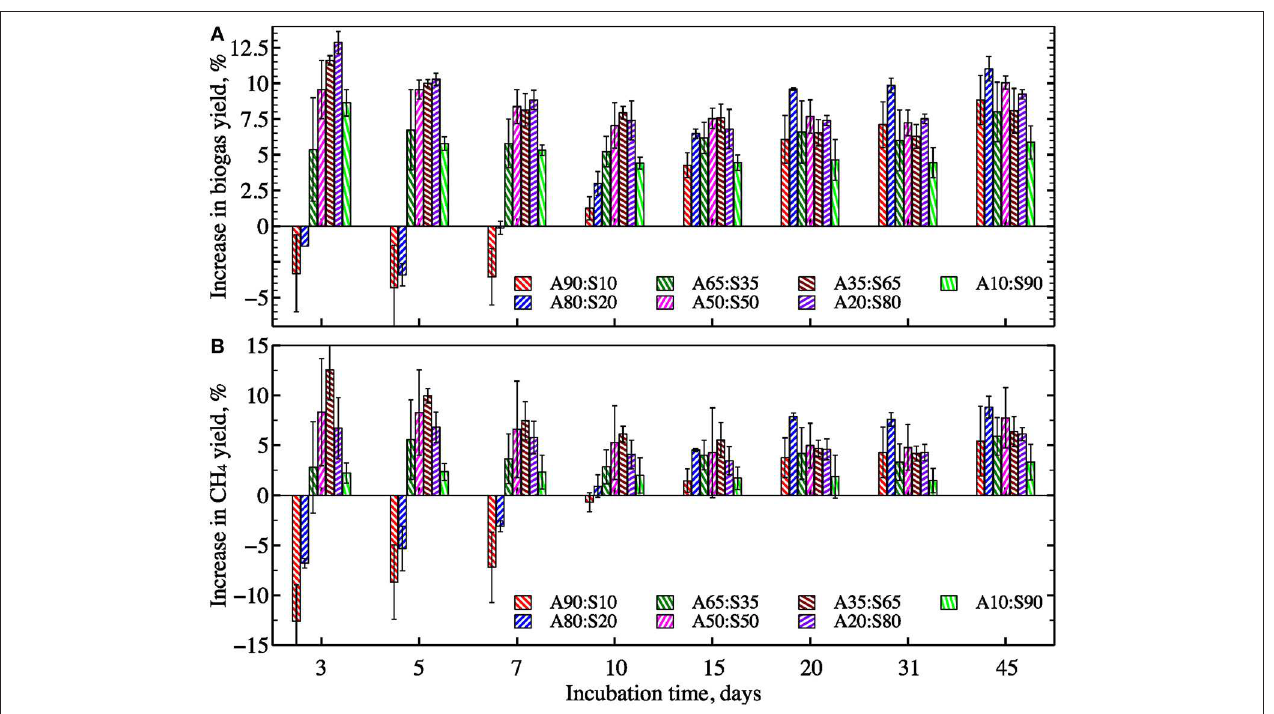
FIGURE 8 | The average synergy effect on biogas (A) and methane (B) yields from algae co-digested at different VS ratios with sewage sludge (see Equation 8) (error bars represent 1 S.D. for three